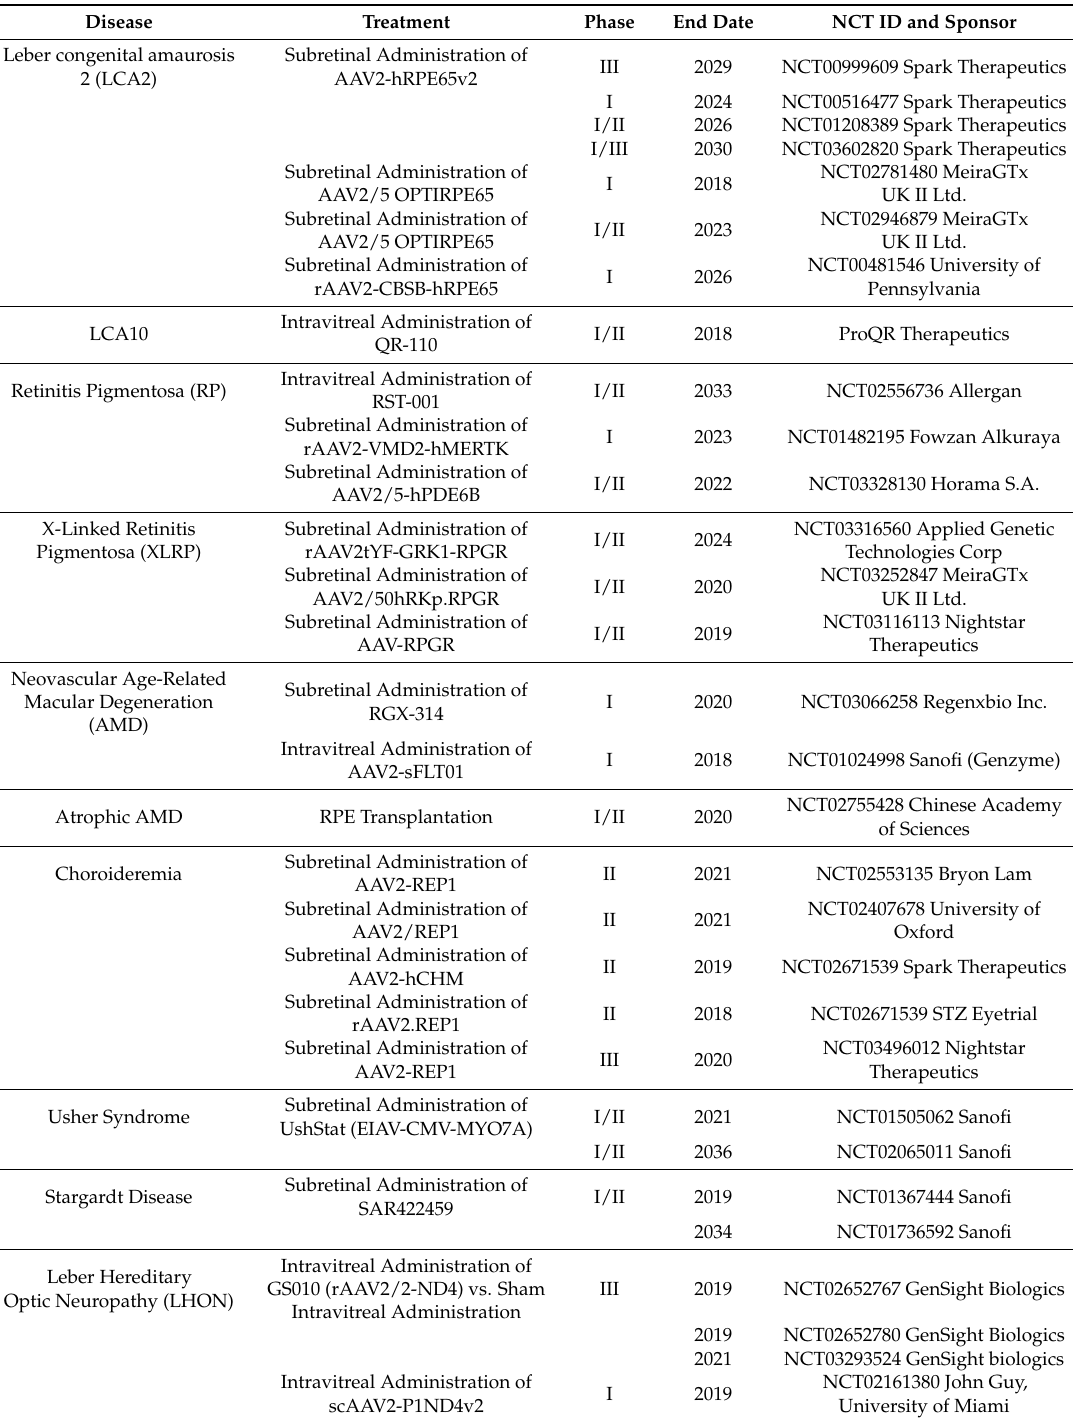
Table A1. Current Gene Medicine Therapy Clinical Trials for Inherited Retinal Disorders.